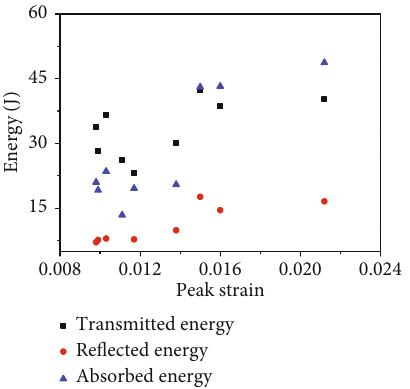
Figure 13: The relationship between energy and peak strain of mudstone